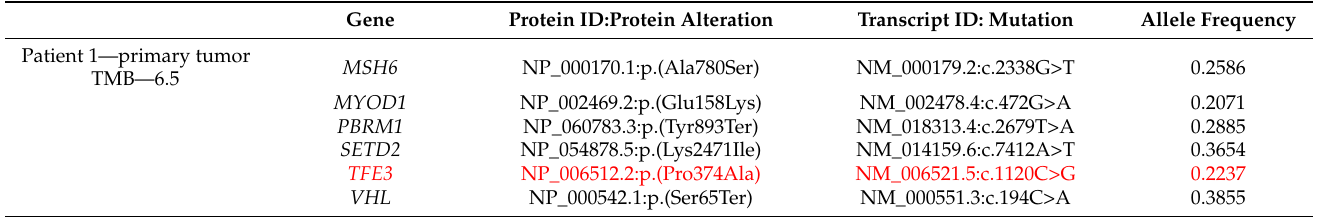
Table 4. Mutational profile of primary tumors and their PMs using TSO500/TS170 panels. Gene Protein ID:Protein Alteration Transcript ID: Mutation Allele